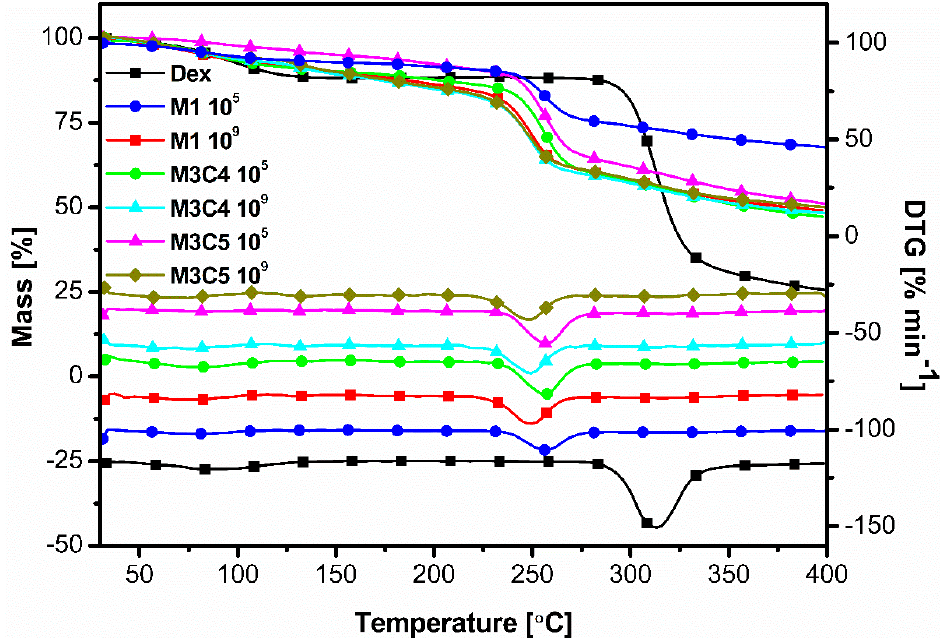
Figure 7. TG and DTG curves of the studied samples. Table 3. Thermal characteristics of the studied samples.